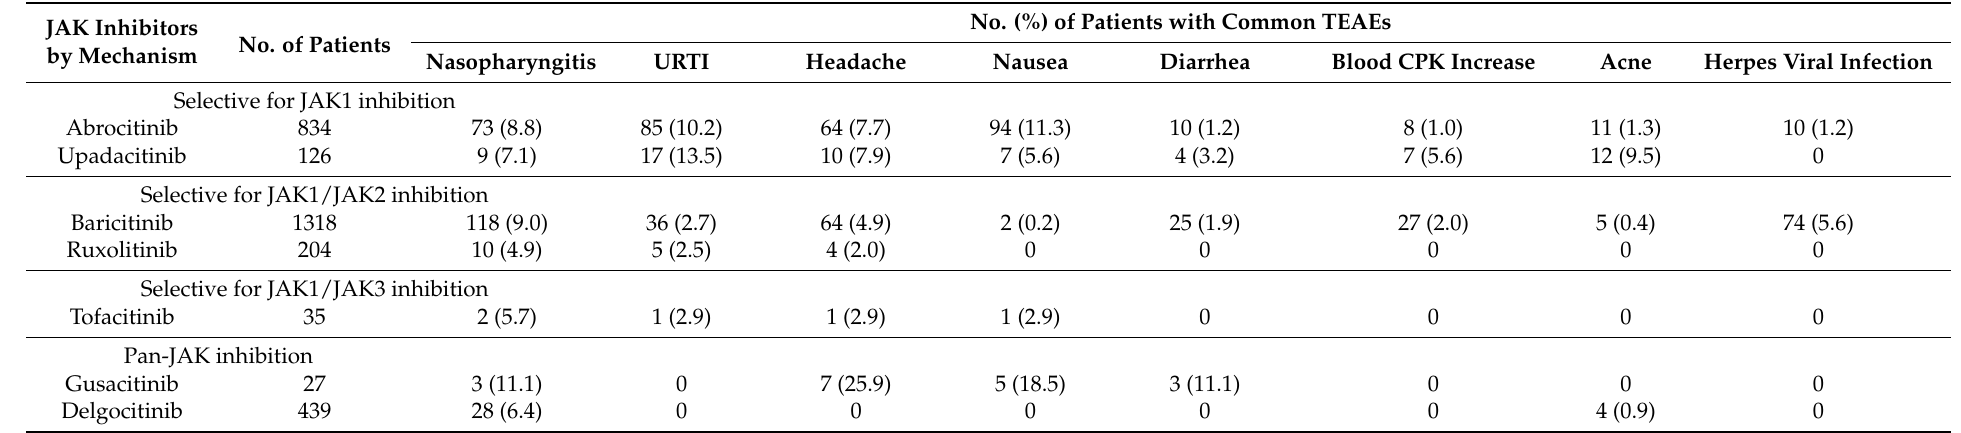
Table 3. Treatment-emergent adverse events reported in the studies included in the